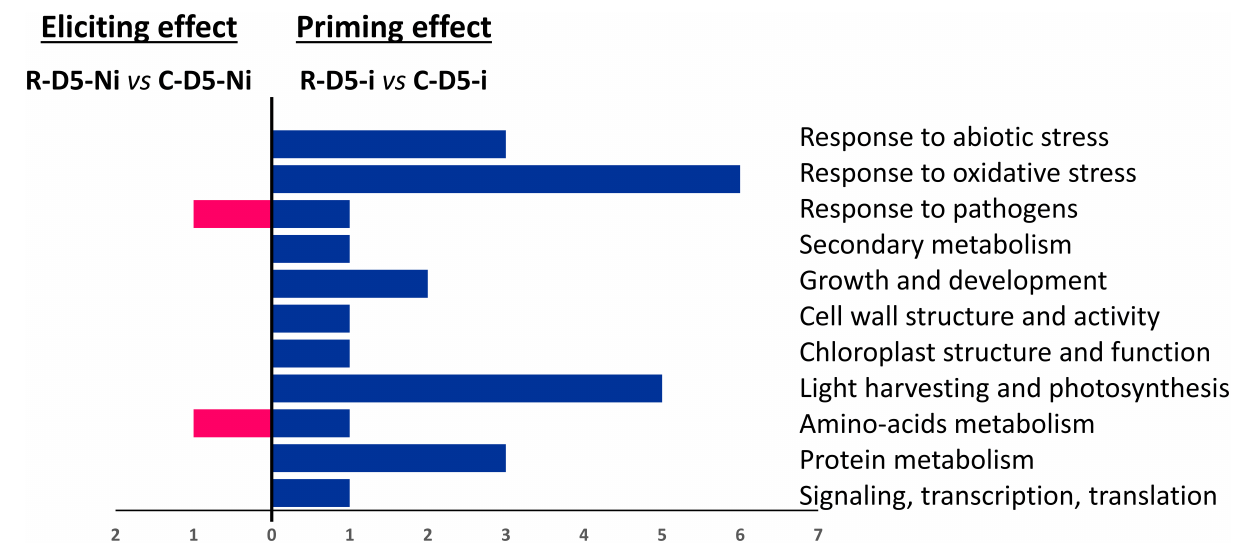
FIGURE 4 | Functional groups of differentially expressed genes (DEGs) observed in eliciting (R-D5-Ni vs. C-D5-Ni) compared to priming (R-D5-i vs. C-D5-i) conditions. DEGs were classified into different functional groups according to NCBI GenBank. C stands for a mock treatment, while R is for Rh-Est-C12 application; Ni relates to mock-inoculated wheat while i means inoculated plants with Z. tritici ; D5 indicates the sampling date of the third leaves, corresponding to 5 days after